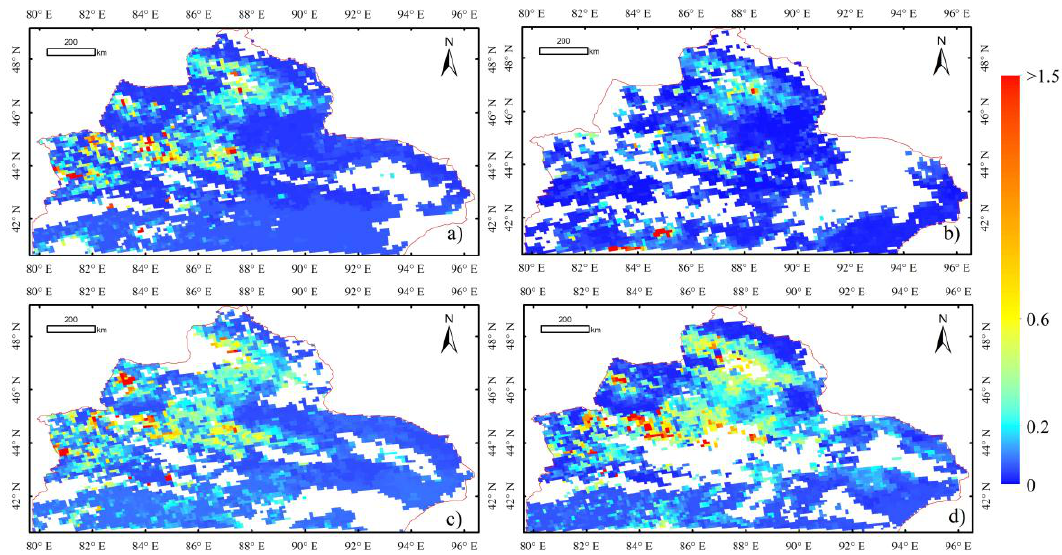
Figure 7. Distribution of MODIS 10-km deep blue (DB) AOD products for the northern Xinjiang area.